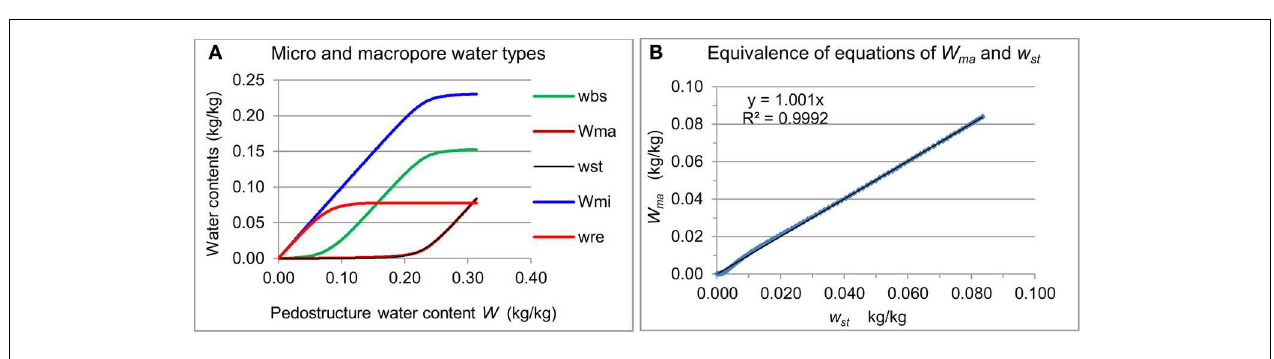
FIGURE 11 | Hydrostructural characterization and modeling of the Rodah soil sample R3. (A) contents according to the total pedostructure water content W , of the different micro and macro-pore